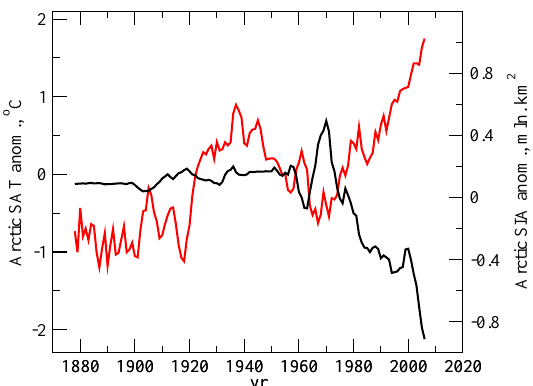
Fig. 1. Arctic (60 ◦ N–90 ◦ N) cold season (November–April) land SAT anomalies ( ◦ C) from CRUTEM3, and NH sea ice area anoma- lies (10 6 km 2 ) from HadISST1.1. A 5-yr running mean filter was applied to both